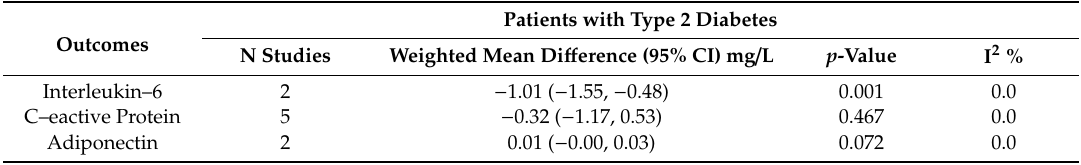
Table 5. Results of a meta-analysis of the e ff ect of a low GI diet on inflammatory